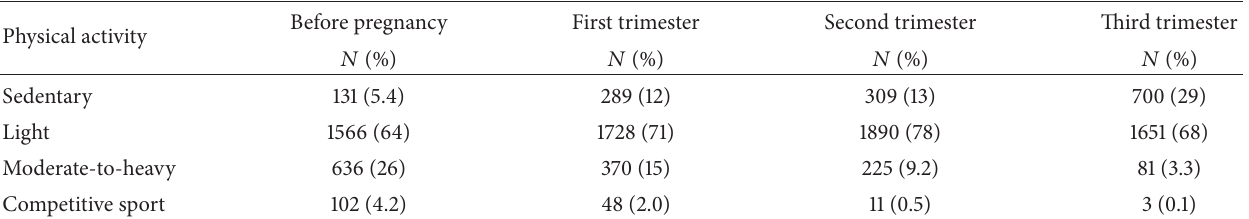
Table1:Physicalactivitylevelstheyearbeforepregnancyandduringfirst,second,andthirdtrimester.TheDanishDystociaStudy,2004-2005. 𝑁 = 2435